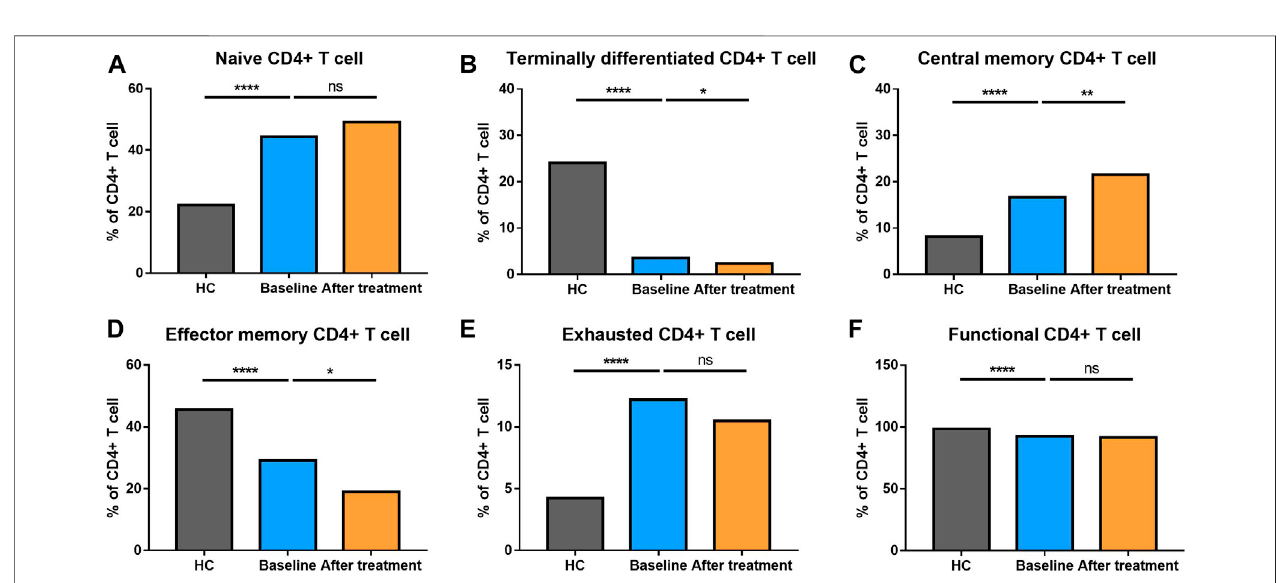
FIGURE 3 | Altered expression of CD4 + T cell subsets in AS patients after treated with secukinumab. The proportion of CD4 + T cell subsets measured by fl ow cytometry at baseline and after receiving secukinumab in AS patients. ns, not signi fi cant; *, p < 0.05; **, p < 0.01; ***, p ≤ 0.001; ****, p < 0.0001 .